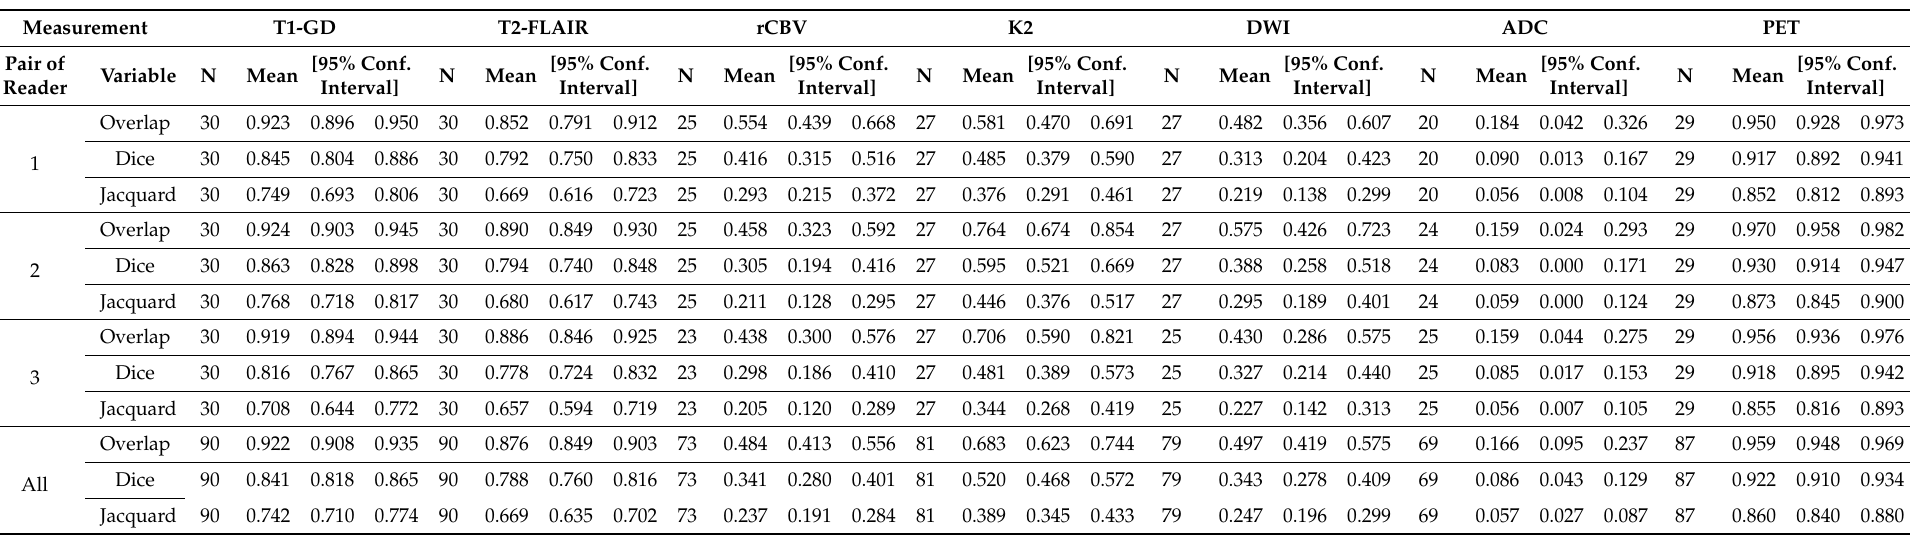
Table 2. Spatial correlation (DSC and JSC) and overlap for each